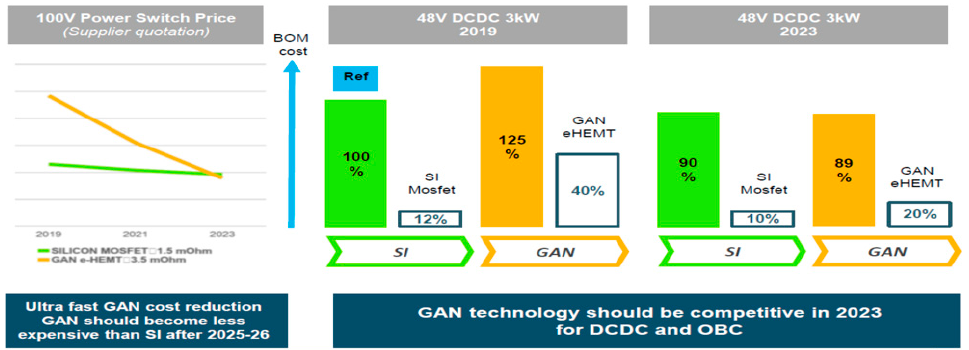
Figure 2. Estimated cost production trend up to 2026.